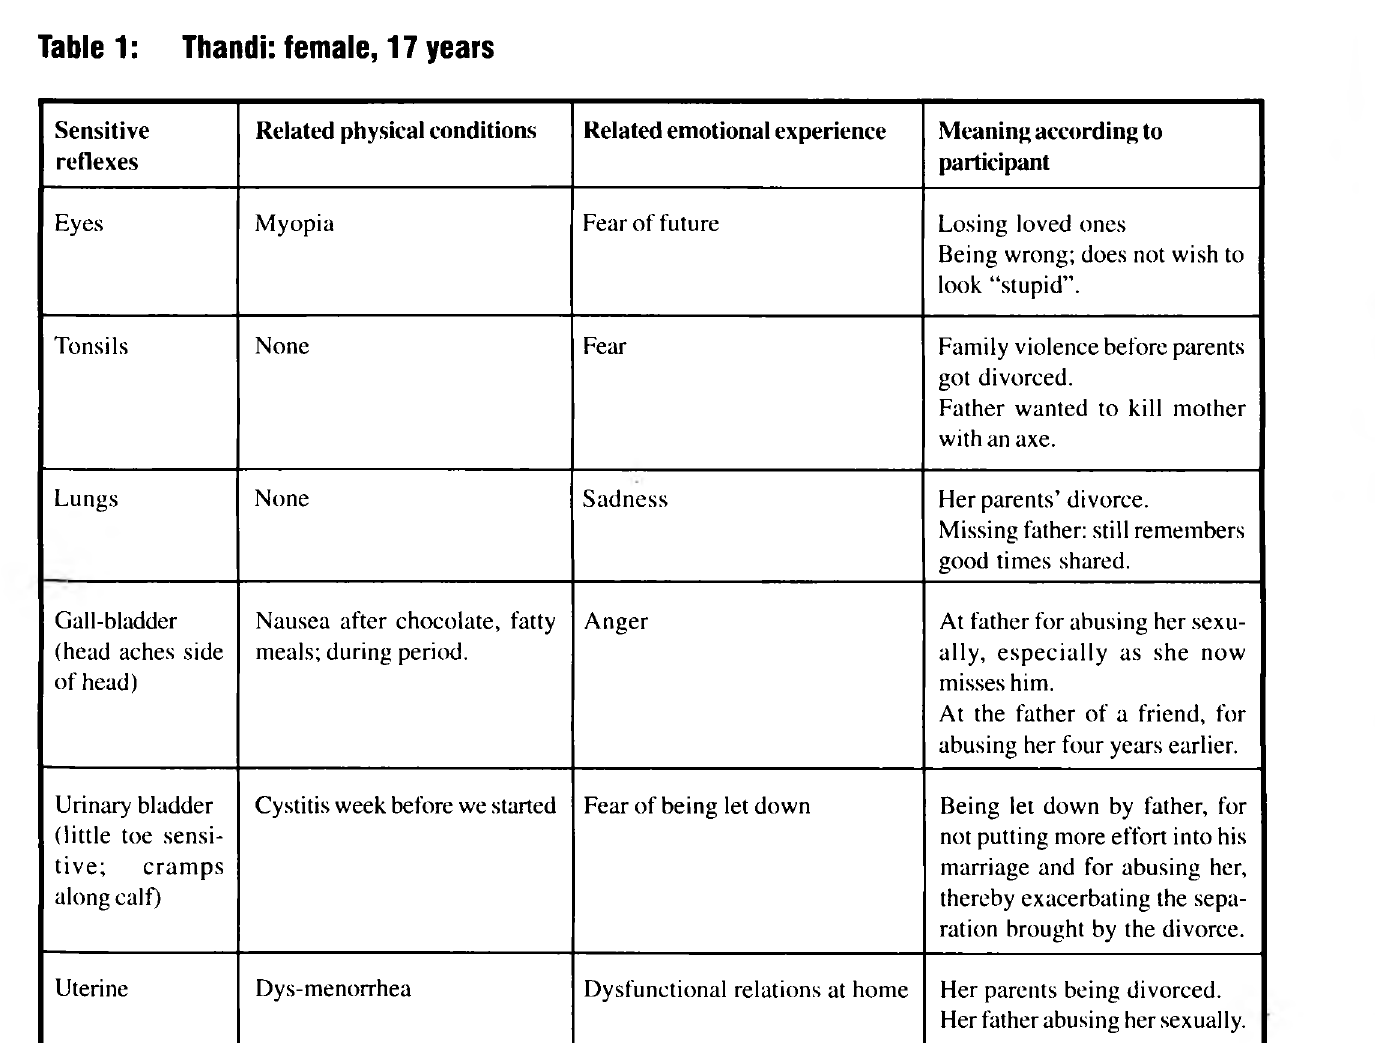
Table 1 : Thandi: female, 1 7